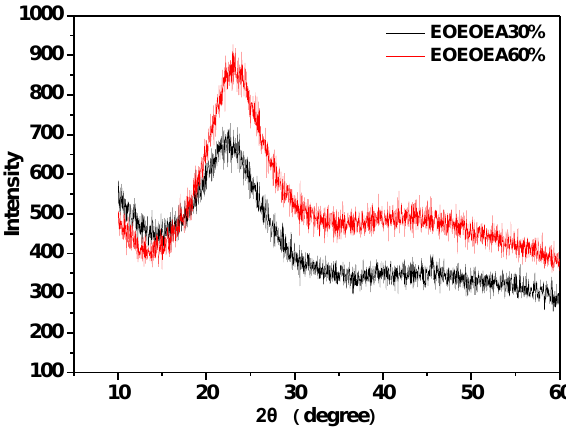
Figure 6. XRD patterns of different gel electrolytes.